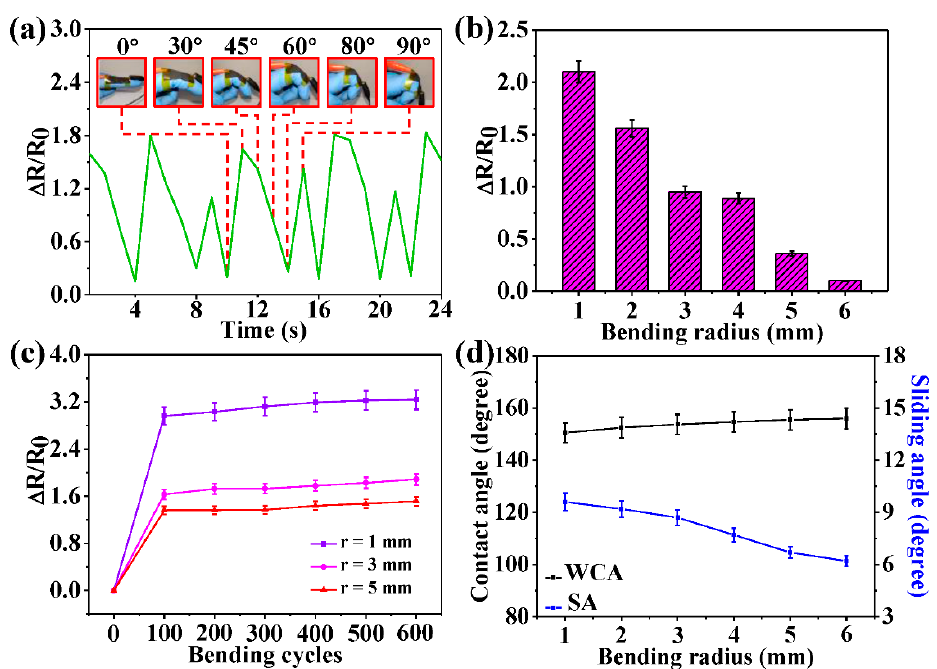
Figure 9. The obtained PI coating is used as an electronic sensor to detect human motion in real time: ( a ) the variation of ∆ R/R 0 with bending time, insets show digital photos of a finger with polyimide film sensors at different bending angles; ( b ) ∆ R/R ∆ R/R 0 variation with different bending radii; ( c ) the change trend in 0 values with the number of bending cycles performed with different bending radii. ( d ) The wettability of the flexible sensor surface after 600 bending cycles performed with different bending